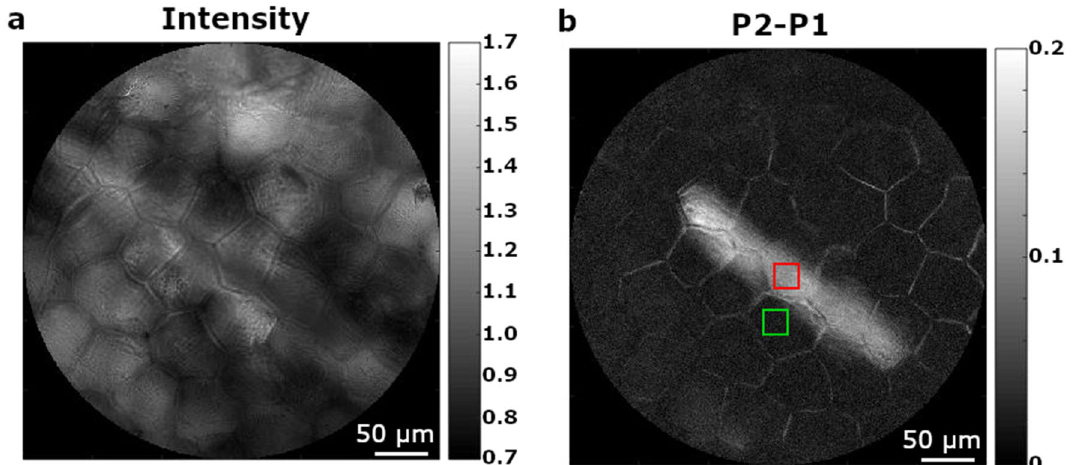
Figure 4. Figure ( a ) shows the intensity image of an inulin raphide out of focal plane (defocused). The corresponding image obtained by using the P 2 –P 1 channel is provided in ( b think that the ability of polarimetric imaging of showing the presence of structures, even being out of focus, is a major advantage as it allows for the identification of biological structures located at different axial planes. The later permits imaging of a given region at the focal plane without loss of resolution while revealing some out of focus structures at the same time. This could be helpful to users without aprioristic information of samples, as polarimetric contrast shows to be very useful to detect relevant structures which may be out of focus. So far, in this section we have seen the improvement associated to polarimetric imaging microscopy, with special mention to the IPPs channels, when compared with standard microscopy. However, other microscopy techniques are well-stablished in biophotonics applications. For the sake of completeness, we include here a set of images taken from the same sample specimen, the Epipremnum aureum leaf, obtained using two of the main optical microscopy techniques used in botanic: phase contrast microscopy and fluorescence microscopy. Phase contrast microscopy allows for the observation of unstained cells 13 and it is especially useful to explore living cells in real time because it does not need the evaluation of multiple images as in polarimetry. Phase con- trast measures differences in the global phase of a light beam between adjacent zones in the sample under exami- nation which are created by small variations in thickness and density (refractive index) among those zones. In phase contrast microscopy, birefringence is not needed to create a visible contrast between two areas of a sample. Phase contrast images of an almost transparent and non-contrasted object give to the human eye the impression of a shaded three-dimensional object. The latter implies a significant improvement in the perception of the sam- ple, and it is in part what is behind the success of this technique. Representative images of stomata and raphides imaged with the phase contrast microscope are shown in Fig. 5a,b, respectively. The leaf piece was imaged using a commercial Olympus Fluoview 1000 phase contrast microscope described in the Methods section. Whereas the stomata are clearly visible in the phase contrast microscopy image (Fig. 5a), with a visibility of V = 0.38 (V is calculated over the purple and yellow regions of Fig. 5a representing the stomata and background respectively), the raphides were no so-well contrasted, presenting a visibility reduced to V = 0.14 (V is calculated over the red and green squared regions of Fig. 5a representing the raphide and background respectively). In Fig. 5b, the loca- tion of a raphide is highlighted by a violet ellipse to help for visualization. In this example, polarimetric images produce more contrasted and more specific images than phase microscopy. Phase contrast performed less well than polarimetry, especially in the case of images of raphides, because the light scattered by raphides depends on the polarization of the incident light and phase contrast microscopy is unable to see that phenomena as it illuminates the sample with unpolarized light. Moreover, colour encoding strategies to enhance image contrast and visibility can be applied in polarimetric imaging because polarimetry consists in multiple independent channels of information whereas in phase-contrast microscopy the information is restricted to only one chan- nel. A second reason why phase contrast performed less well than polarimetry in the example discussed here is the fact that the sample was not thin, i.e., limited to a single monolayer of cells. In these circumstances, phase shifts larger than 2π can cumulate and produce grey scales which do not linearly relate to variations in sample thickness or density, therefore degrading the performance of the technique. Phase contrast and polarimetry can be complementary because they can be used in non-stained samples. In polarimetry, some channels are specific to the manifestation of a property in the sample, such as retardation or dichroism. In this way, while phase- contrast provides an enhanced view of the tridimensional conformation of the object, polarimetric observables can highlight aspects related to certain specific properties of the sample. Images of the same areas of the leaf explored under phase contrast imaging were taken with the same Olympus Fluoview 1000 commercial microscope previously cited, operated in fluorescent mode. The use of specific dyes selected to link to the molecules that are of interest for the observations, makes fluorescence microscopy a highly specific and highly resolved technique. By using two different fluorescent dyes, images of well contrasted and differentiated stomata (Fig. 5c) and raphide (Fig. 5d) were obtained. Although the visualization of the raphide structure is comparable with that obtained by using polarimetric channels (Fig. 2b–d), the stoma image shows